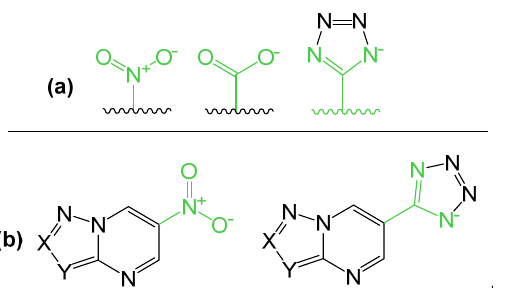
Figure 3. ( a ) Isosterism of tetrazole ring, carboxylic fragment and nitro group. ( b ) Potent nitro- azolopyridimidines and tetrazolyl-containing analogues as perspective alternative.